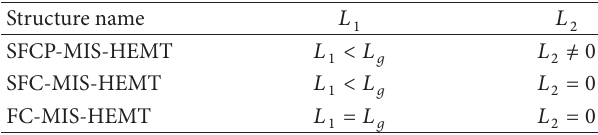
Figure 3: (a) Influence of 𝑄 1 on conduction band; (b) 2DEG density of the three different MIS-HEMTs at on state; (c) 2DEG density of the three different MIS-HEMTs in the drift region at off state. Table 1: Abbreviations and parameters of three